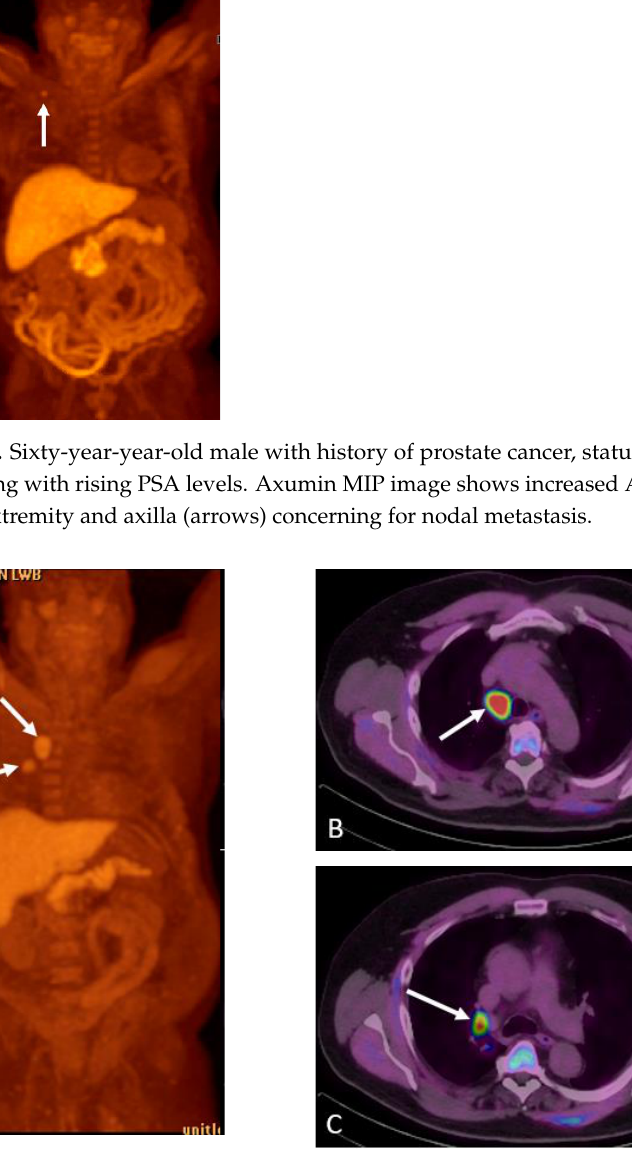
Figure 9. Sixty-seven-year-old man with history of prostate cancer status post-prostate, and salvage radiotherapy with rising PSA. Axumin MIP ( A ) and fused PET/CT ( B , C ) demonstrated right lower paratracheal and hilar lymphadenopathy (arrows) concerning for metastases from prostate cancer or a secondary lung primary. Endobronchial ultrasound fine needle aspiration demonstrated adenocarcinoma consistent with prostate primary cancer. Patient was treated with androgen deprivation therapy and localized radiotherapy with nadir to undetectable PSA.